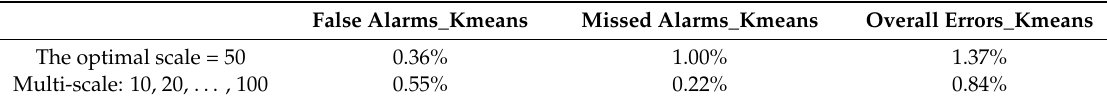
Table 7. Comparison between the change detection results of the single-scale and multi-scale proposed method, with L2 as the basis image in the second study area. False Alarms_Kmeans Missed Alarms_Kmeans Overall Errors_Kmeans The optimal scale = 50 0.36% 1.00% 1.37% Multi-scale: 10, 20, . . . , 100 0.55% 0.22%